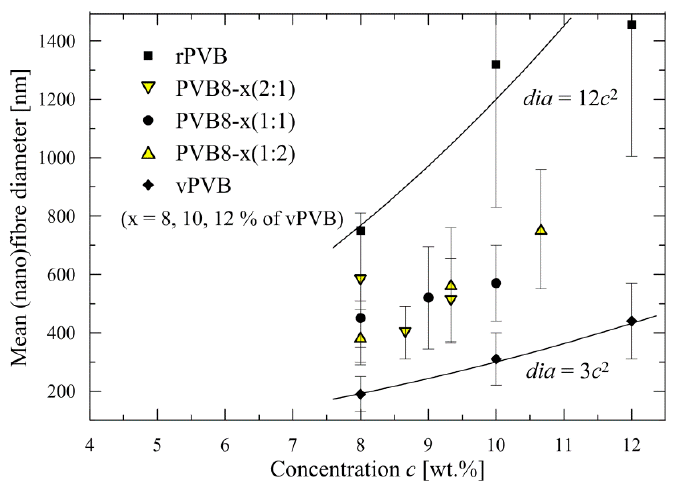
Figure 7. Mean nanofiber diameters for recycled, blended and virgin PVB.